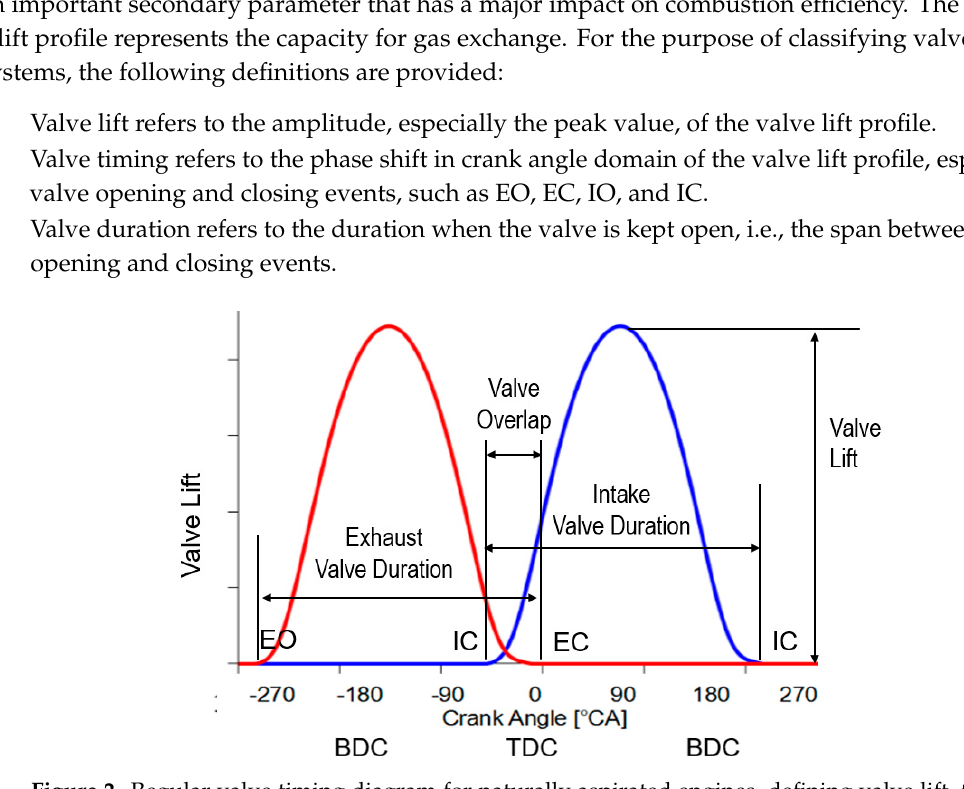
Figure 2. Regular valve timing diagram for naturally aspirated engines, defining valve lift, timing, and and duration.